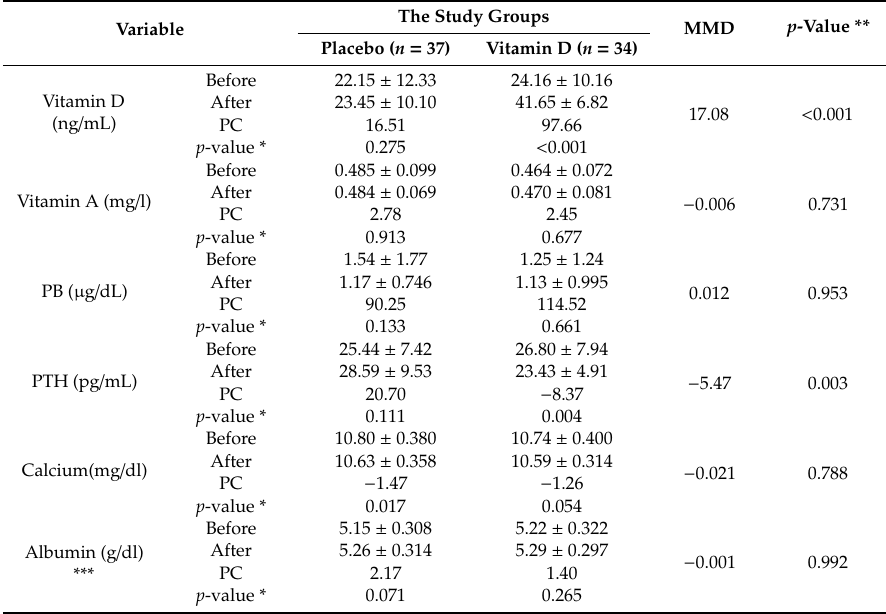
Table 3. Comparing the serum levels of vitamin D, vitamin A, PB and PTH in the study groups before and after